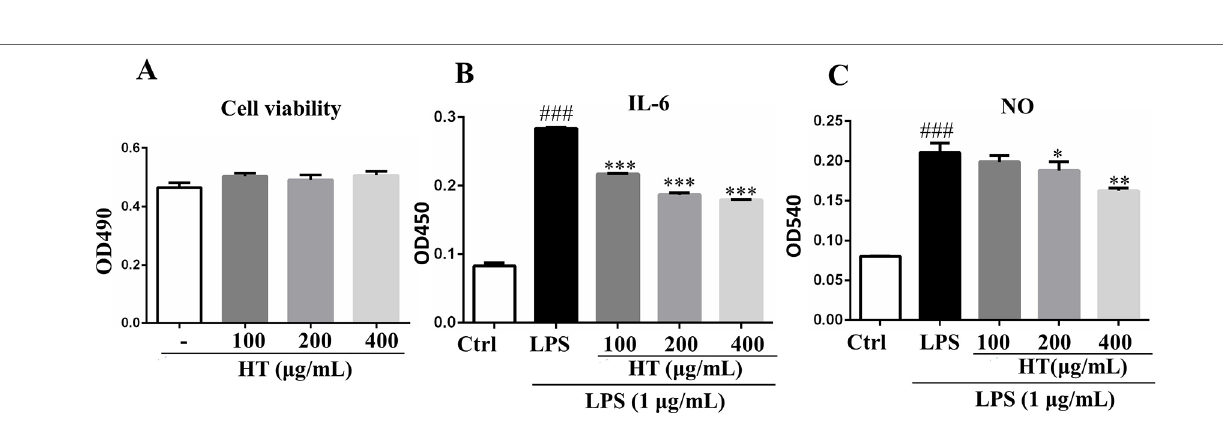
FIGURE 4 | Effects of HT on RAW264.7 cells in the presence or absence of lipopolysaccharide (LPS). The cells were cotreated with the extracts in 96-well plate at indicated concentrations for 24 h; then, the cell viability was detected by 3-(4,5-dimethylthiazol-2-yl)-2,5-diphenyltetrazolium bromide (MTT) assay (A) . The cells were pretreated with the extracts at the concentrations of 100, 200, and 400 μg/ml in 24-well plate for 1 h, then stimulated with LPS (1 μg/ml) for 24 h; the supernatants were collected to determine cytokines secretion with ELISA kit (B) and NO release with Griess reagent (C) . Data are presented as the mean ± SD ( n = 3). ### P < 0.001 vs. the Ctrl group. * P < 0.05, ** P < 0.01, *** P < 0.001 vs. the LPS